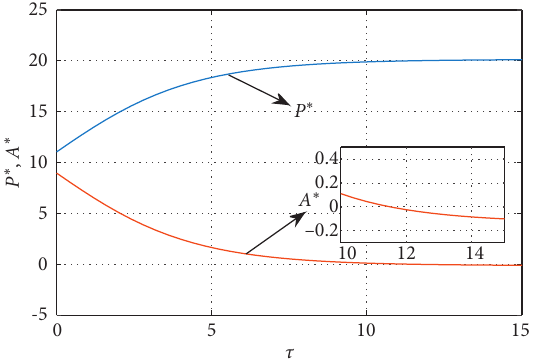
Figure 4: The equilibrium E ∗ of system (4) is unstable with τ � 6.